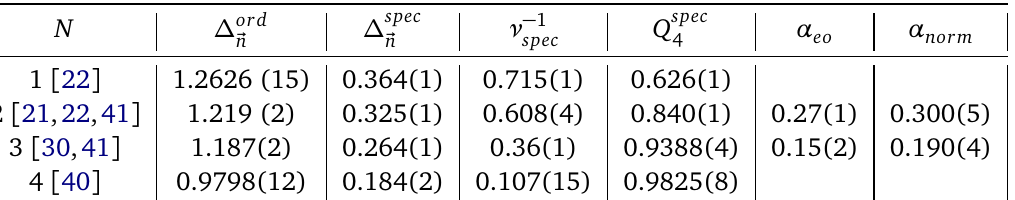
Table 1: Monte Carlo results for surface criticality in the classical O ( N ) model in d = 3. ∆ ord and ∆ spec are respectively the scaling dimensions of the surface order (cid:126) n (cid:126) n parameter at the ordinary and special fixed points. ν is the correlation length spec = 〈 (cid:126) m 2 1 〉 exponent at the special transition. Q spec 4